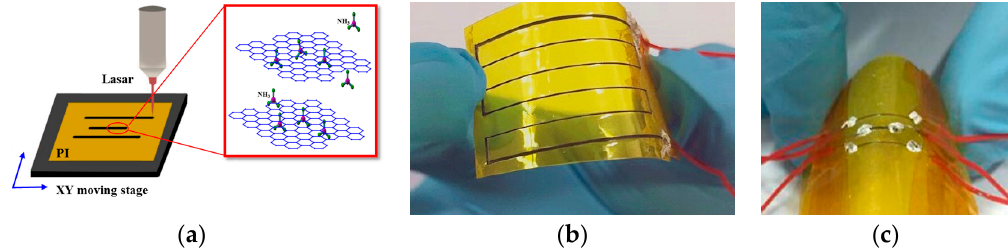
Figure 1. ( a ) A diagram of laser direct writing; ( b ) A photo of a flexible zigzag pattern fabricated by laser direct writing; ( c ) A photo of a test sample of the